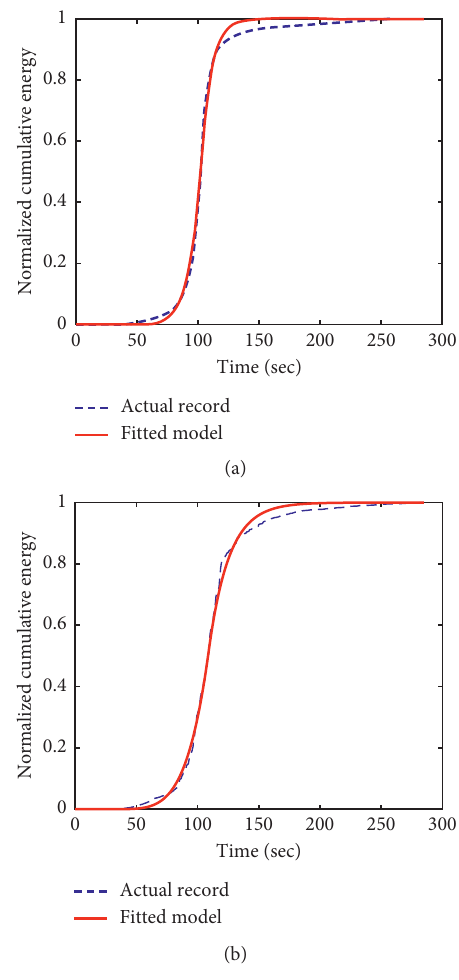
Figure 11: Normalized cumulative energy curves for records